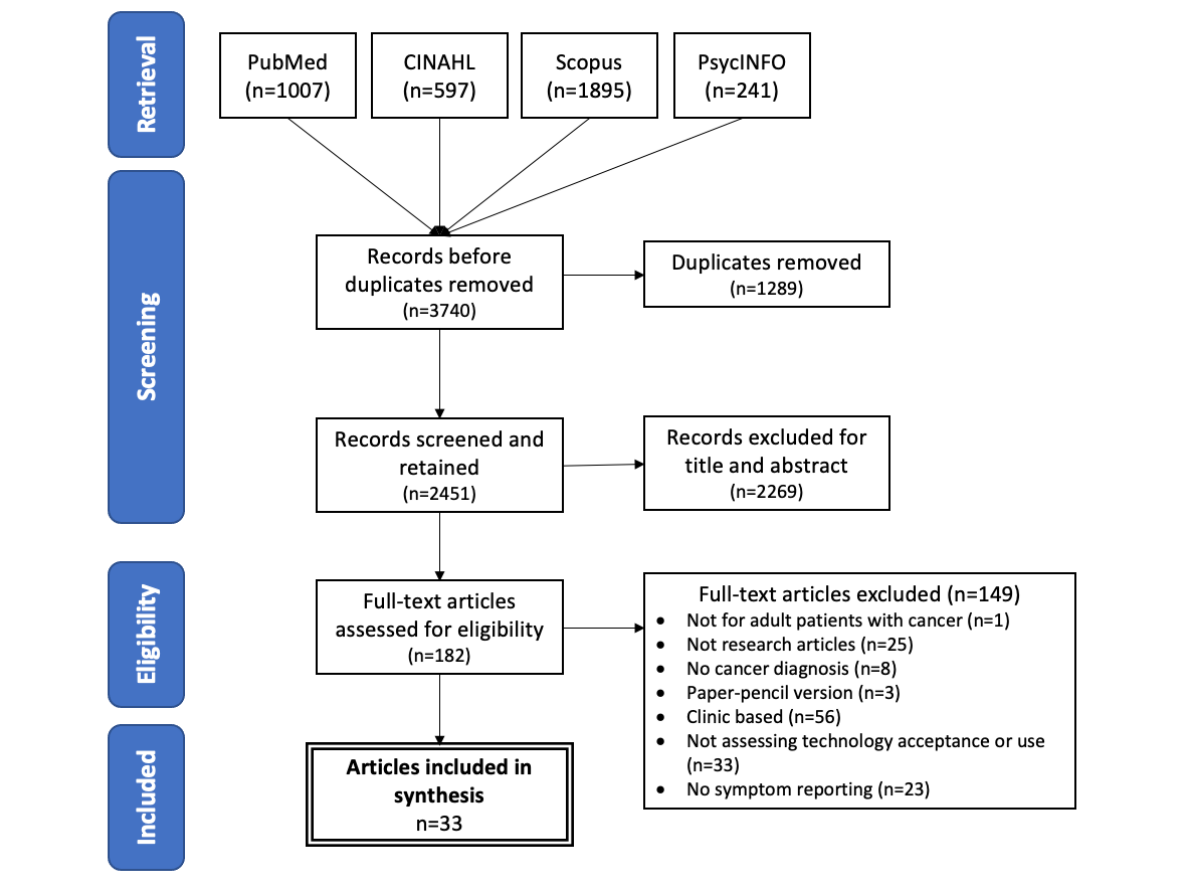
Figure 1. PRISMA (Preferred Reporting Items for Systematic Reviews and Meta-Analyses)